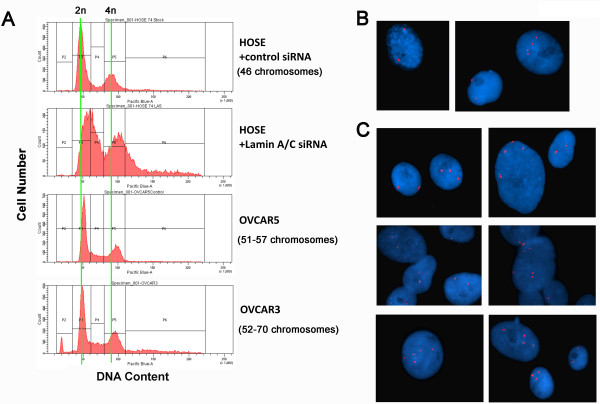
Lamin A/C suppression in primary ovarian epithelial cells results in increased nuclear size, aneuploidy, and polyploidy. Primary HOSE cells were transfected with control or shRNA to suppress lamin A/C and were subjected to analysis for DNA content and ploidy. (A) The shRNA-treated and control HOSE cells were sorted by flow cytometry to compare DNA content. Two aneuploid ovarian cancer cell lines, OVCAR5 (51 to 57 chromosomes per cell) and OVCAR3 (52 to 70 chromosomes per cell) were analyzed for comparison. A subtle increase in DNA content was observed in lamin A/C-suppressed HOSE cells. (B) In situ hybridization with X chromosome centromere probe of control HOSE cells treated with scrambled shRNA. Two representative fields are shown. (C) In situ hybridization with X centromere probe of lamin A/C-suppressed HOSE cells. Six representative fields are shown for the presence of 3, 4, and other multiple X-chromosome-containing nuclei.